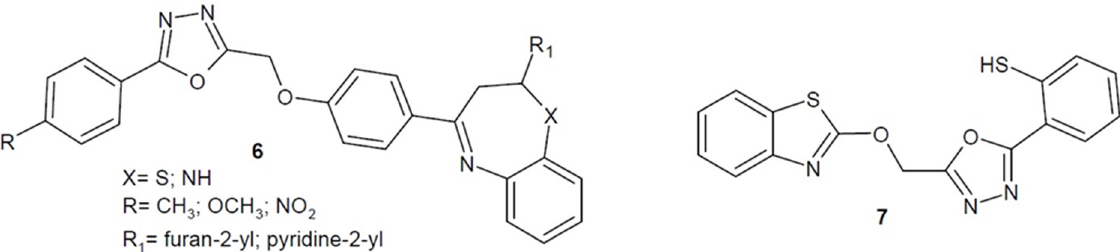
Figure 4. Aryl-1,3,4-oxadiazole derivatives with antibacterial activity. 1,3,4-oxadiazole derivatives directly containing an aryl and/or a heteroaryl (five or six membered ring) substituent also have antibacterial activity.